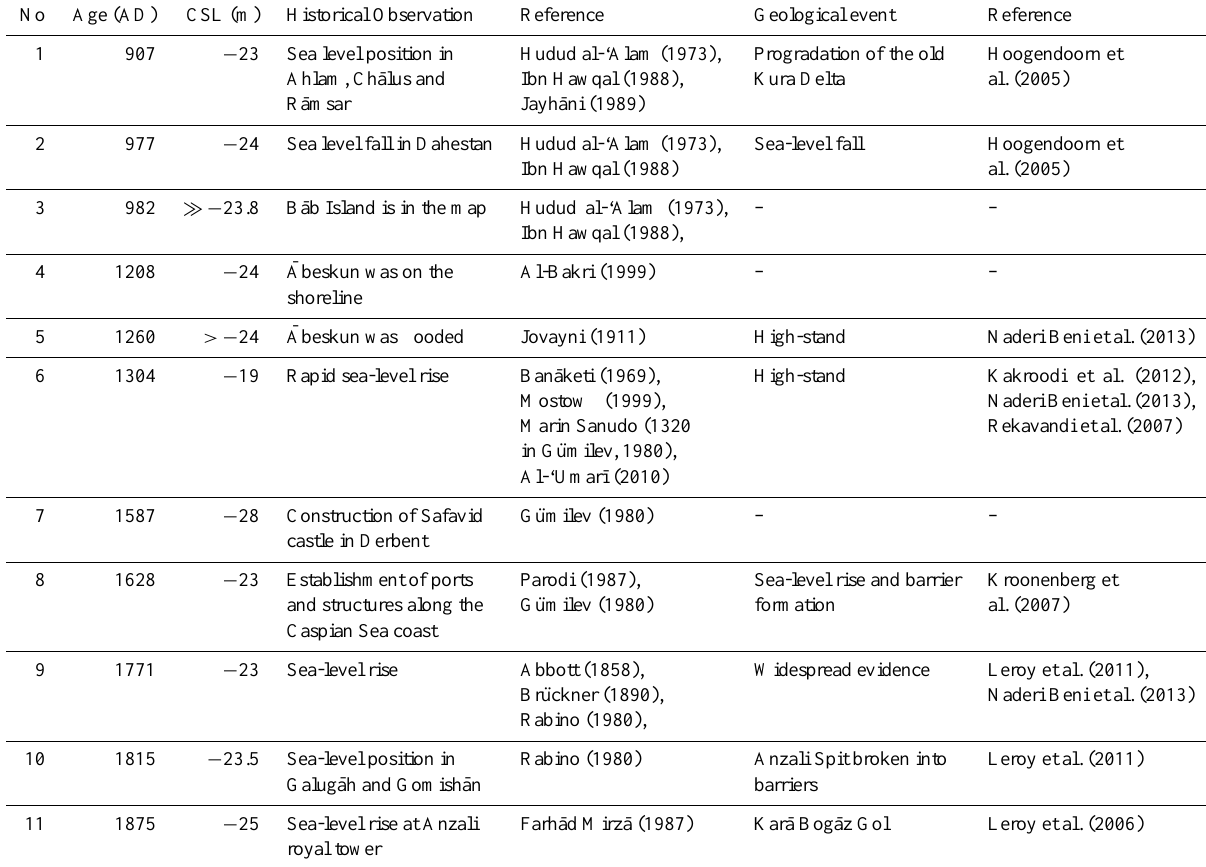
Table 7. The Caspian sea level (CSL) during the last millennium based on comparison between historical observations and geological events. No Age (AD) CSL (m) Historical Observation Reference Geological